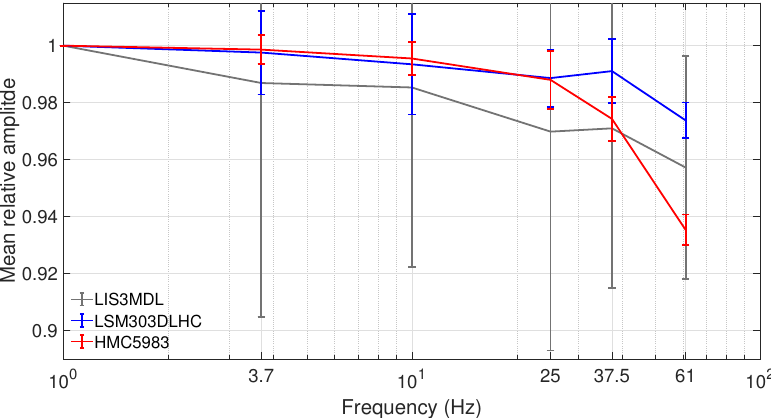
Figure 6. Mean relative amplitudes for all three sensor models, with standard deviation error depicted by error bars. All amplitudes are normalized with the value at 1Hz.